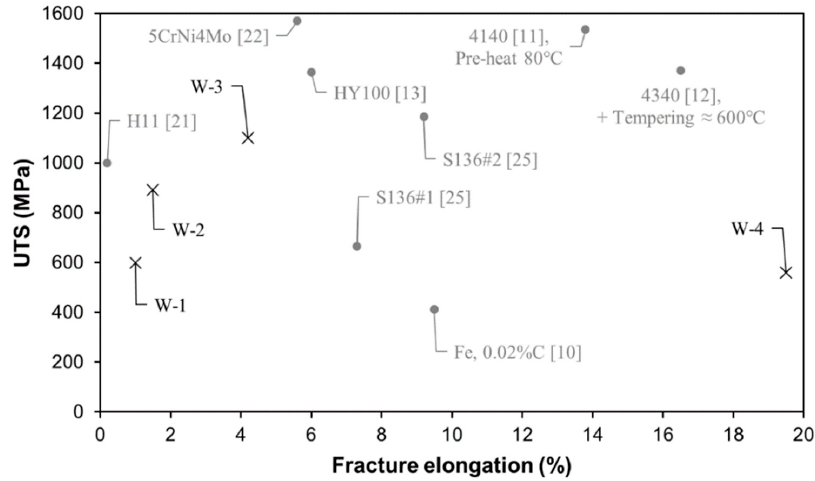
Figure 15. Mechanical performance of the investigated water atomisation (WA)-steels compared to the literature data.